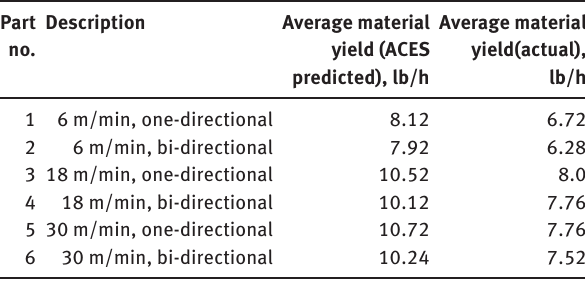
Table 3 Comparison of material